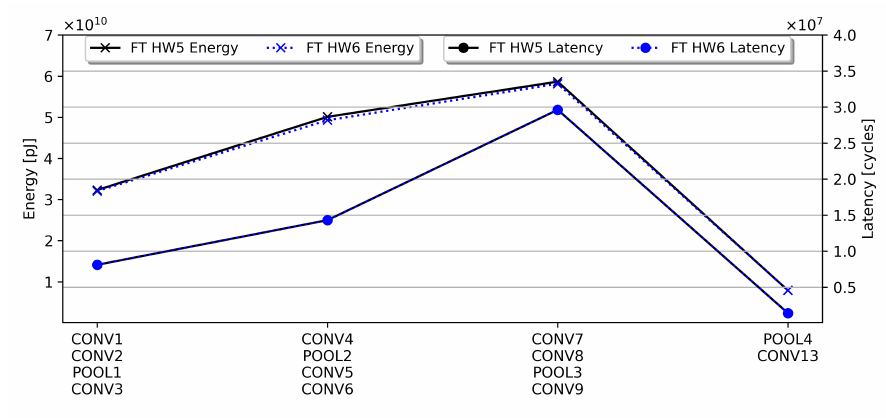
Figure 17. Energy and latency for VGG16, mapped with temporal fusion with HW config. 5 and 6.